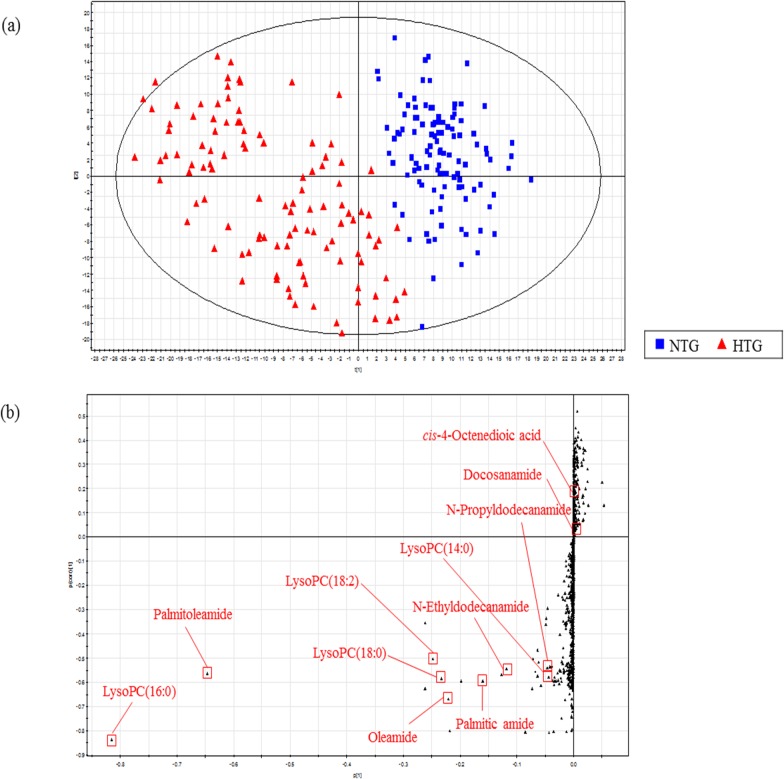
Identification of plasma metabolites in the NTG and HTG groups.(a) Score scatter plot from the PLS-DA model for the NTG group (n = 111) and HTG group (n = 111). (b) S-plot for the covariance [p] and reliability correlation [p(corr)] from the PLS-DA model.